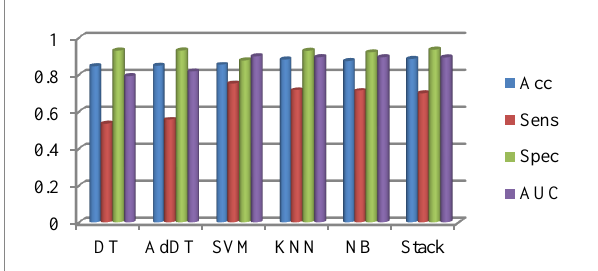
Figure 1. Performance of six classifiers used in the study from four different performance indicator views (average of 12 model performance for each algorithm).